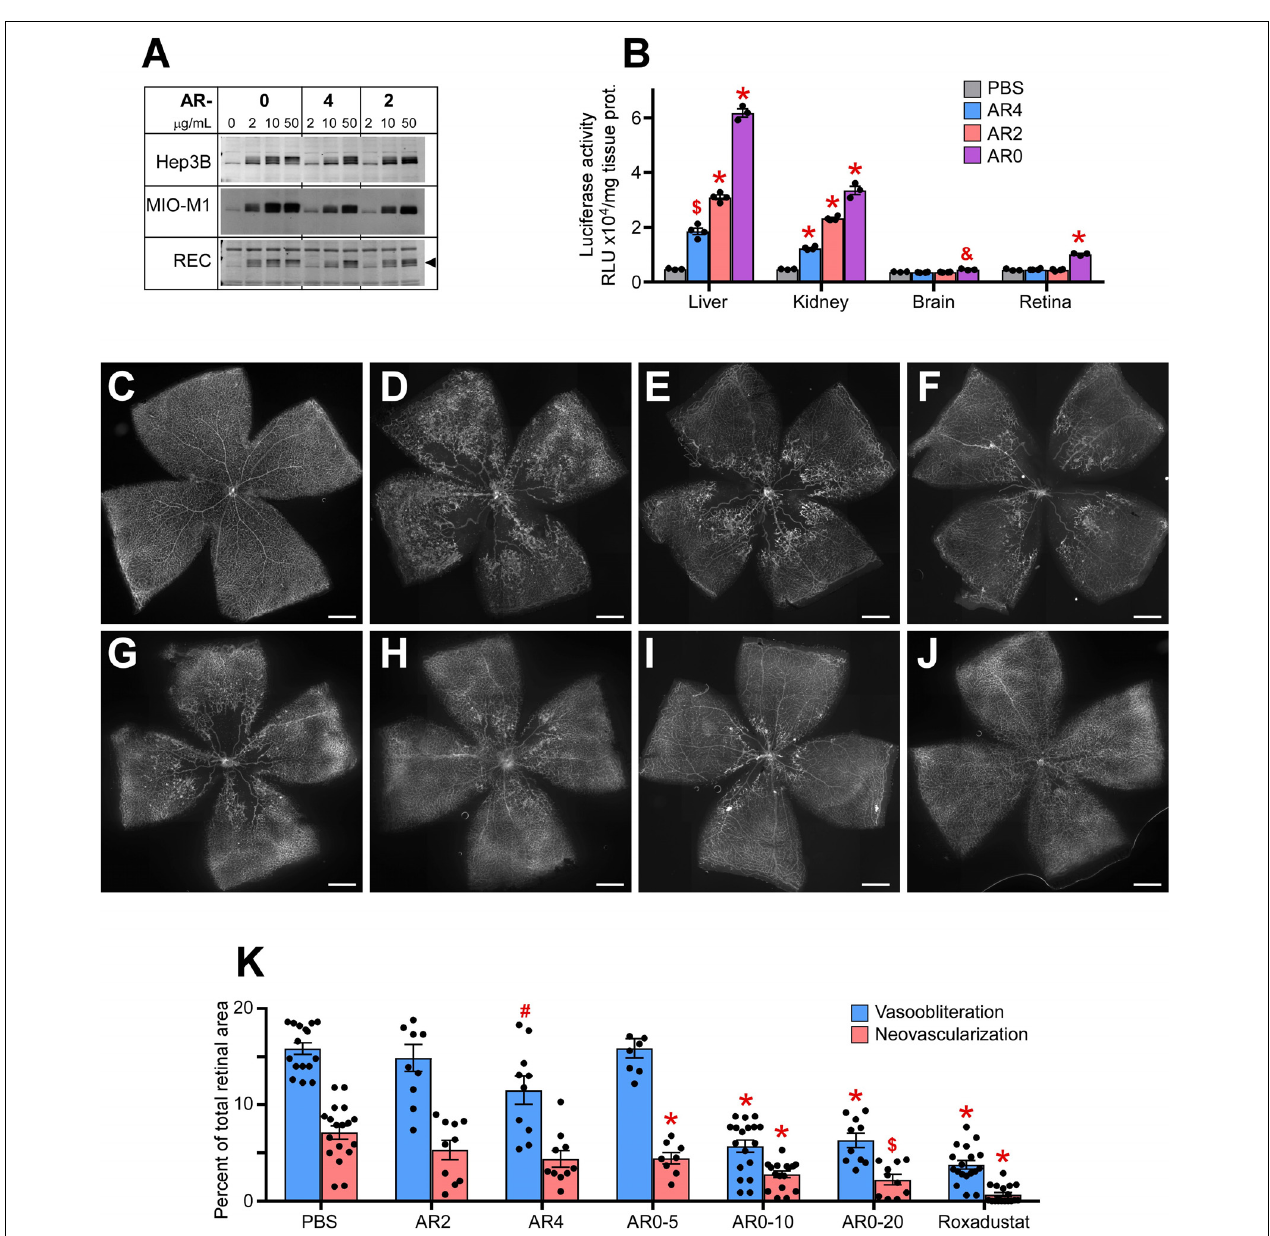
FIGURE 2 | Potency of AR compounds in HIF stabilization and prevention of OIR. (A) Western blot analysis of HIF-1 α protein levels in three types of cultured cells treated overnight with the indicated concentrations of AR0, AR4 or AR2. (B) Luciferase activity in tissue homogenates of P8 Luc-ODD mouse pups 3 h after injections of PBS (control), AR4 (40 µ g/g), AR2 (40 µ g/g) or AR0 (20 µ g/g) expressed as RLU/mg tissue protein. PBS, n = 3; AR4, n = 5; AR2 = 5: AR0, n = 4. (C–J) Representative retinal flatmounts of the naïve room air reared (C) or hyperoxia-challenged (D–J) P17 mouse pups according to the OIR protocol, who were treated with PBS (D) , 40 µ g/g AR4 (E) , 40 µ g/g AR2 (F) , 5 µ g/g AR0 (G) , 10 µ g/g AR0 (H) , 20 µ g/g AR0 (I) or 10 µ g/g Roxadustat (J) . Scale bar = 500 µ m. (K) Quantitative analysis of retinal flatmount images shown in panels (D–J) for areas of capillary loss (vasoobliteration) and vascular tufting (neovascularization). PBS, n = 16; AR2, n = 10; AR4, n = 10; AR0-5, n = 8; AR0-10, n = 18; AR0-20, n = 10; Roxadustat, n = 18. P values are presented as follows, * ≤ 0.0001; $ ≤ 0.005; & ≤ 0.01; # ≤ 0.05, and represent statistical difference vs PBS control.